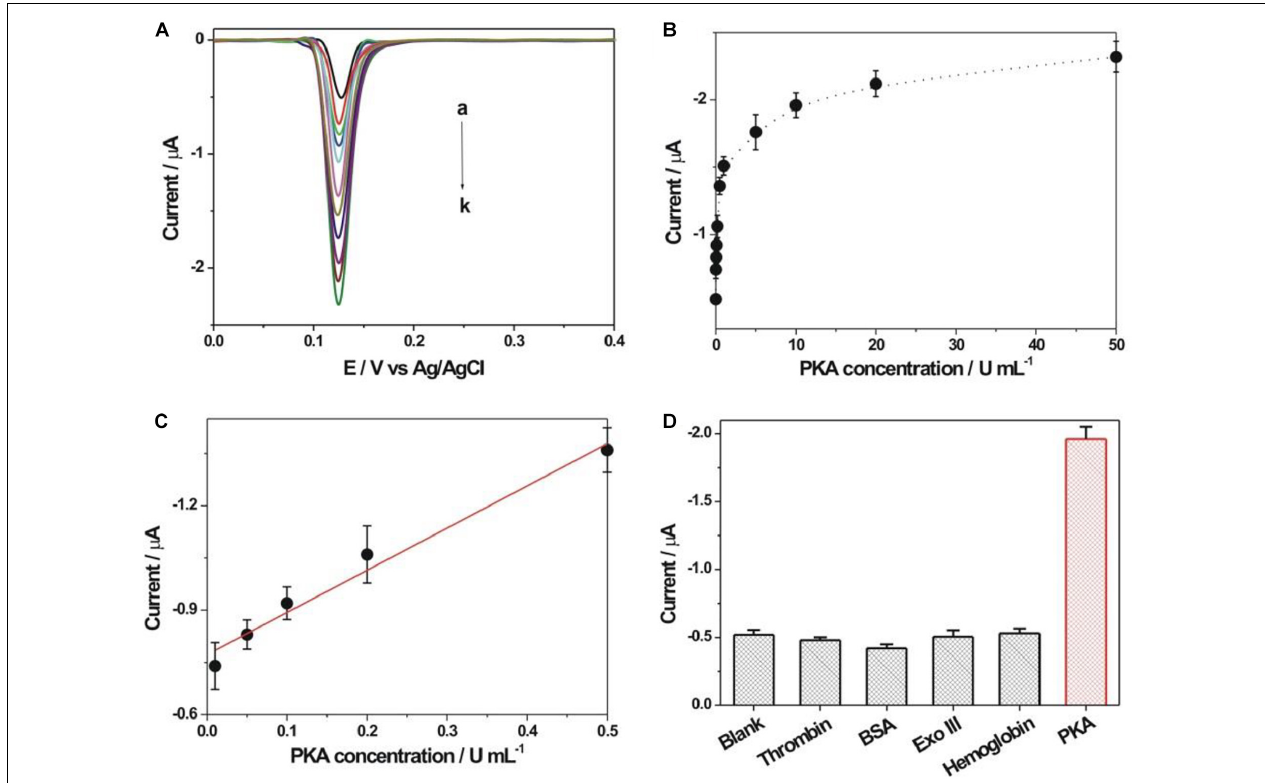
FIGURE 5 | (A) DPV responses obtained at different concentrations of PKA. The PKA concentrations from curve a to k were 0, 0.01, 0.05, 0.1, 0.2, 0.5, 1, 5, 10, 20, and 50 U/mL, respectively. (B) Calibration curve of DPV response vs. PKA concentration. (C) The linear plot between DPV peak current and PKA concentration.